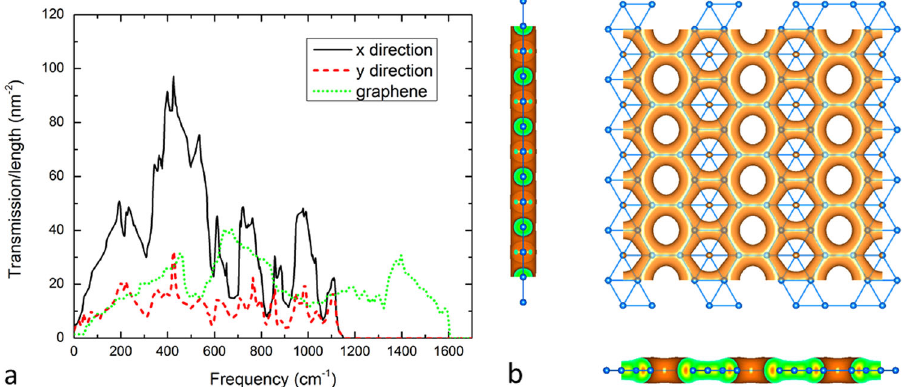
Fig. 7 Phonon transmission and electron density distribution of β 12 borophene. a Phonon transmission function of β 12 borophene. b Isosurface plot at 0.15 Å − 3 for electron density distribution of β 12 borophene in both top and side